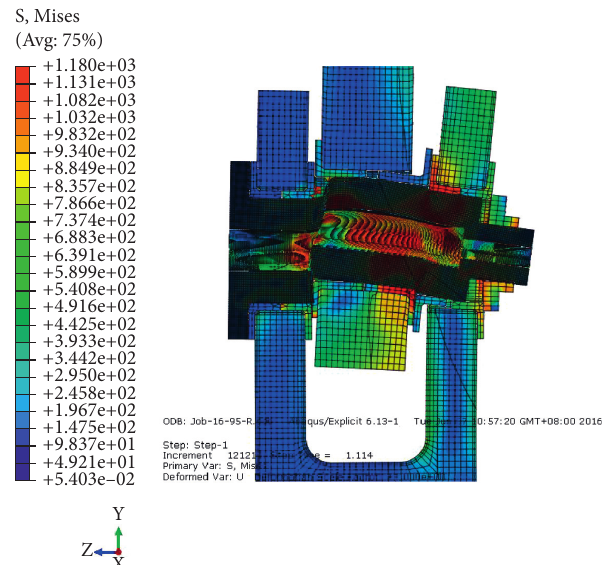
Figure 17: Equivalent stress contour of the fuse pin assembled at the point of